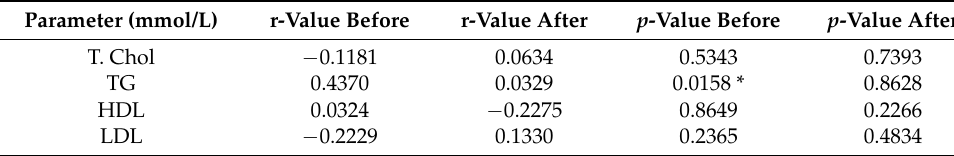
Table 6. Correlation between SP-Lyase and